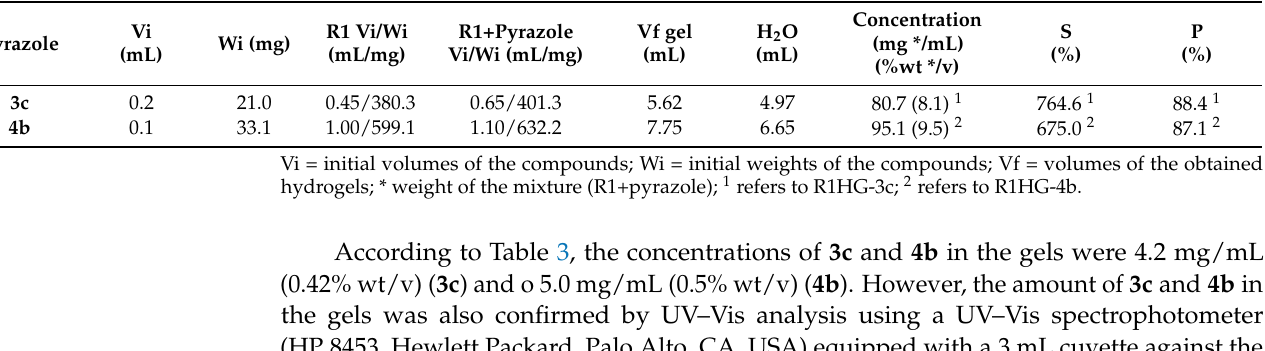
Table 3. Data concerning the preparation of pyrazole-enriched hydrogels R1HG-3c and R1HG-4b.